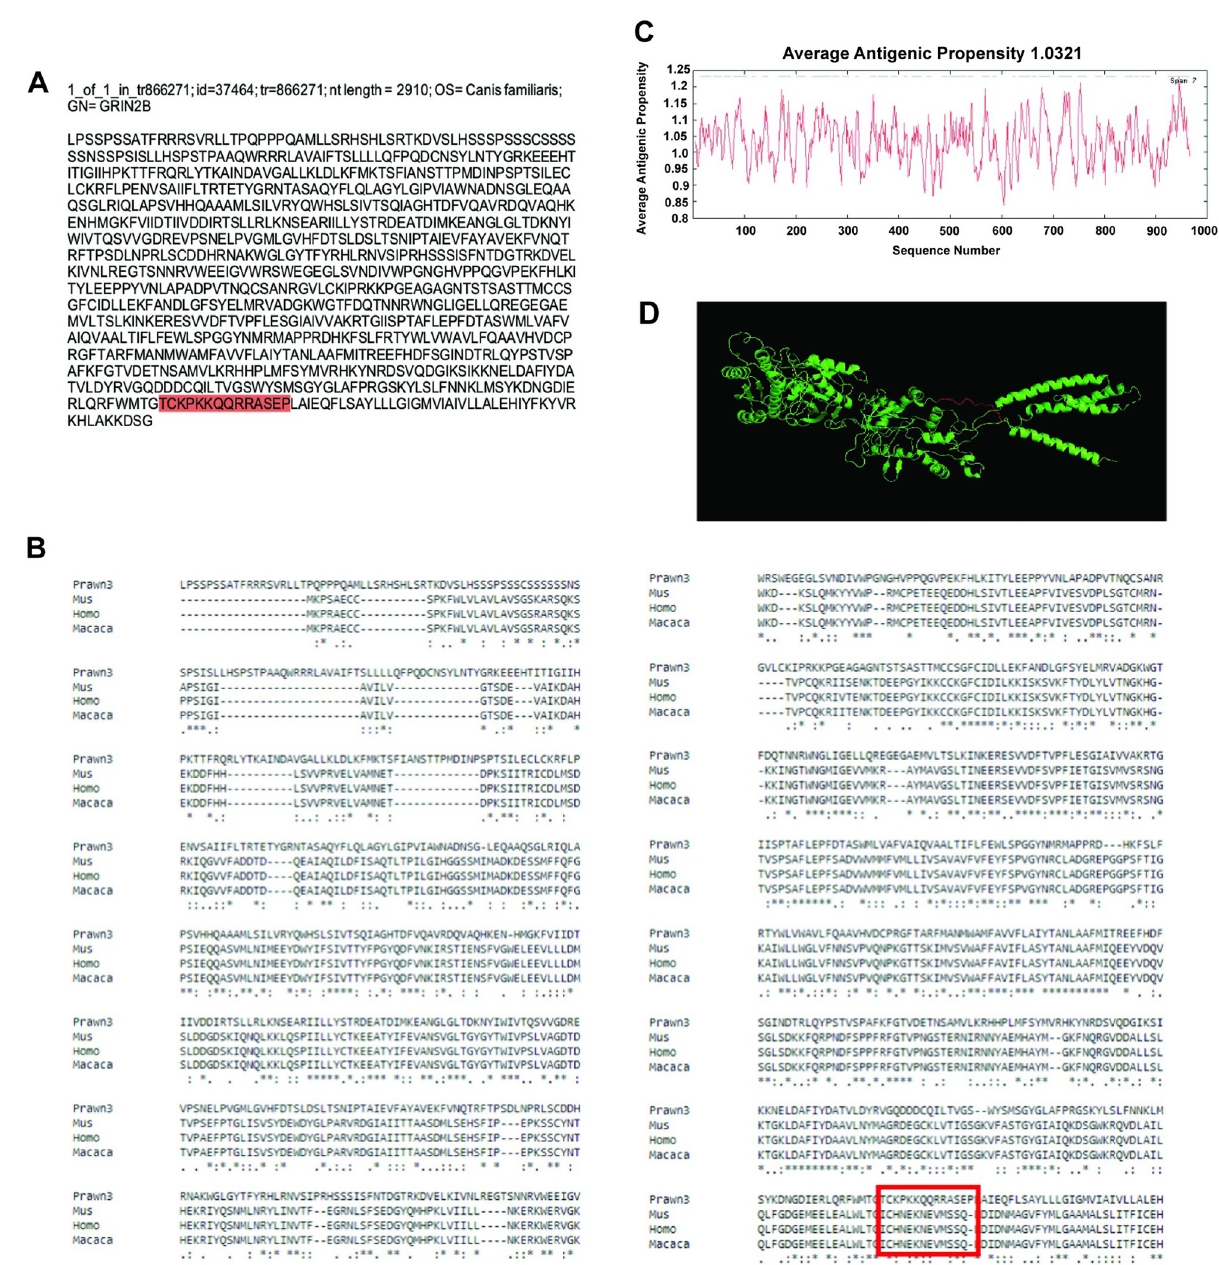
Fig 7. Contig annotated as ionotropic glutamate receptor NMDA 2B analysis for antibody production. A) Contig identifiers for NMDA 2B in the M . carcinus transcriptome and its sequence translated into amino acids for further analysis. B) Multiple sequence alignments of the prawn´s contig compared to the same protein in other species: a rodent M . musculus , human primate H . sapiens , and the non-human primate M . mulatta . Regions of conserved amino acids are shown within the red box. C) Average antigenic propensity value was 1.0321, showing 37 determinants (peaks in graph) within the sequence that are good candidates for antigenic response. D) A 3D reconstruction model showing tertiary structures of the prawn NMDA 2B contig sequence. The red highlight in A, rectangle in B and segment in D represent the selected sequence for antibody production. elucidating antigenic properties, in part due to the great length of the sequence (Fig 7c). After antigenicity analysis, the sequence selected for recognition with an antibody against this contig was: TCKPKKQQRRASEP, located at the extracellular side between residues 912–925 (Fig 7a and 7b; red highlight and red rectangle respectively). The 3D model reconstruction of the